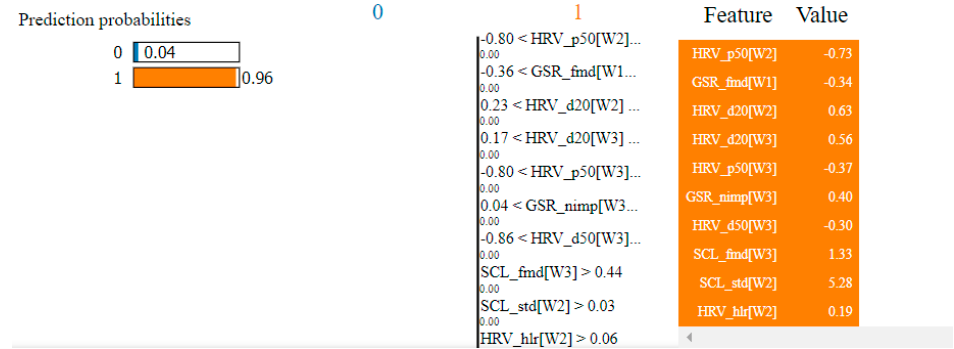
Figure 26. Prediction features for situation 1 (fear), for the non-overlapping dataset.